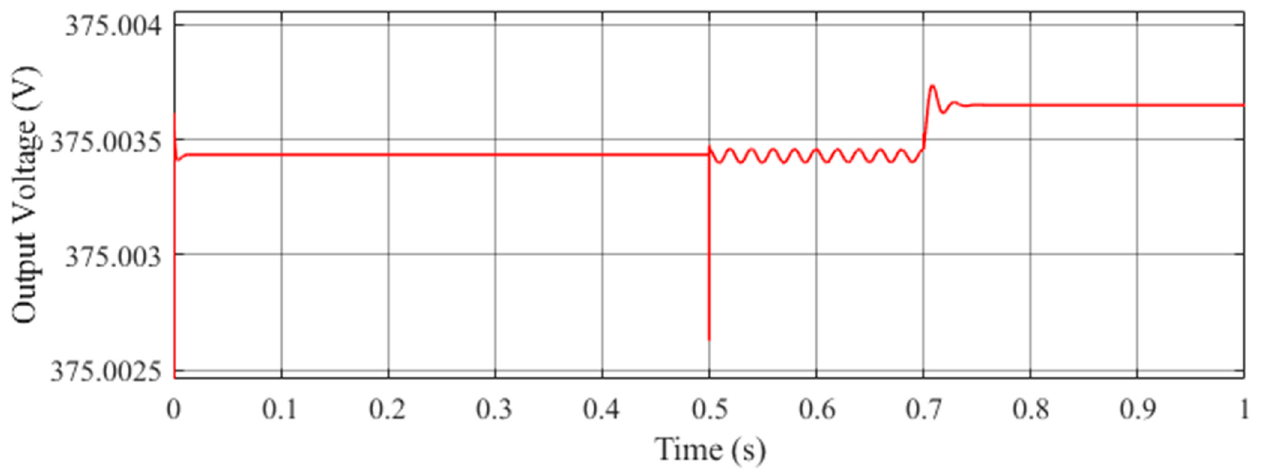
Figure 15. Voltage regulation during fault.